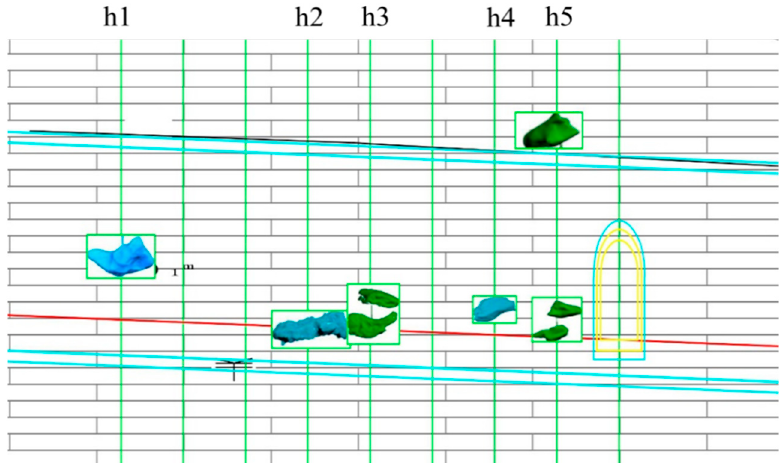
Figure 15. Karst cave distribution map.